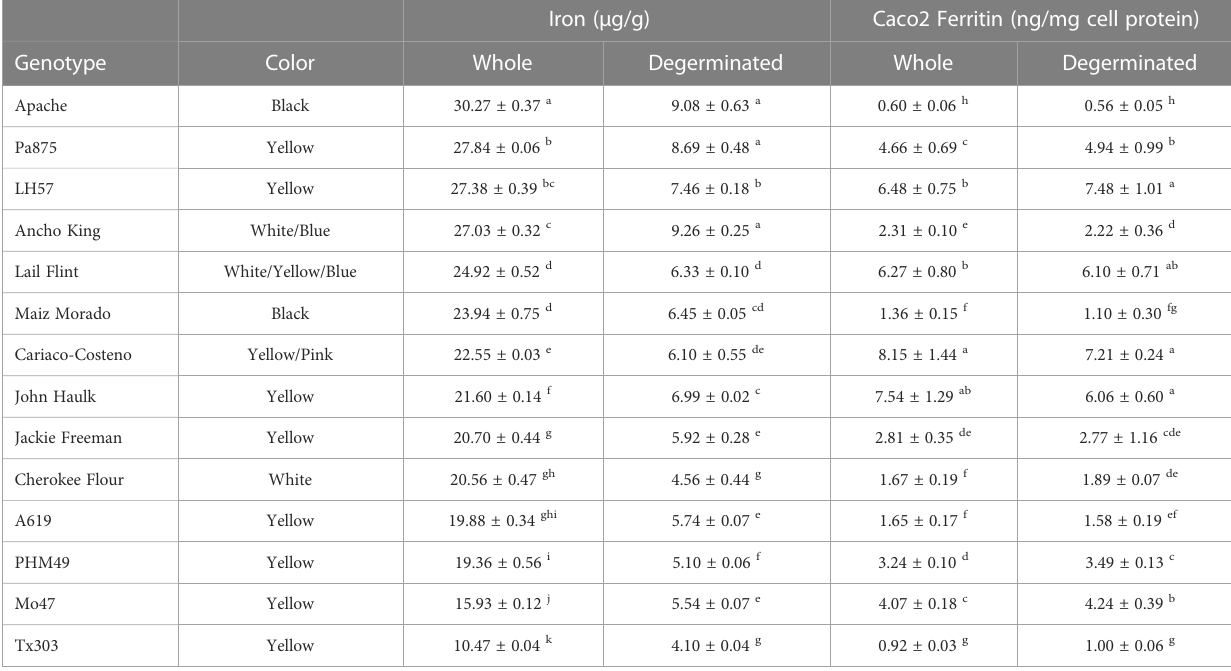
TABLE 3 Description and iron concentrations of maize genotypes that had no change in their iron bioavailability after removing the germ fraction (degerminated) 1